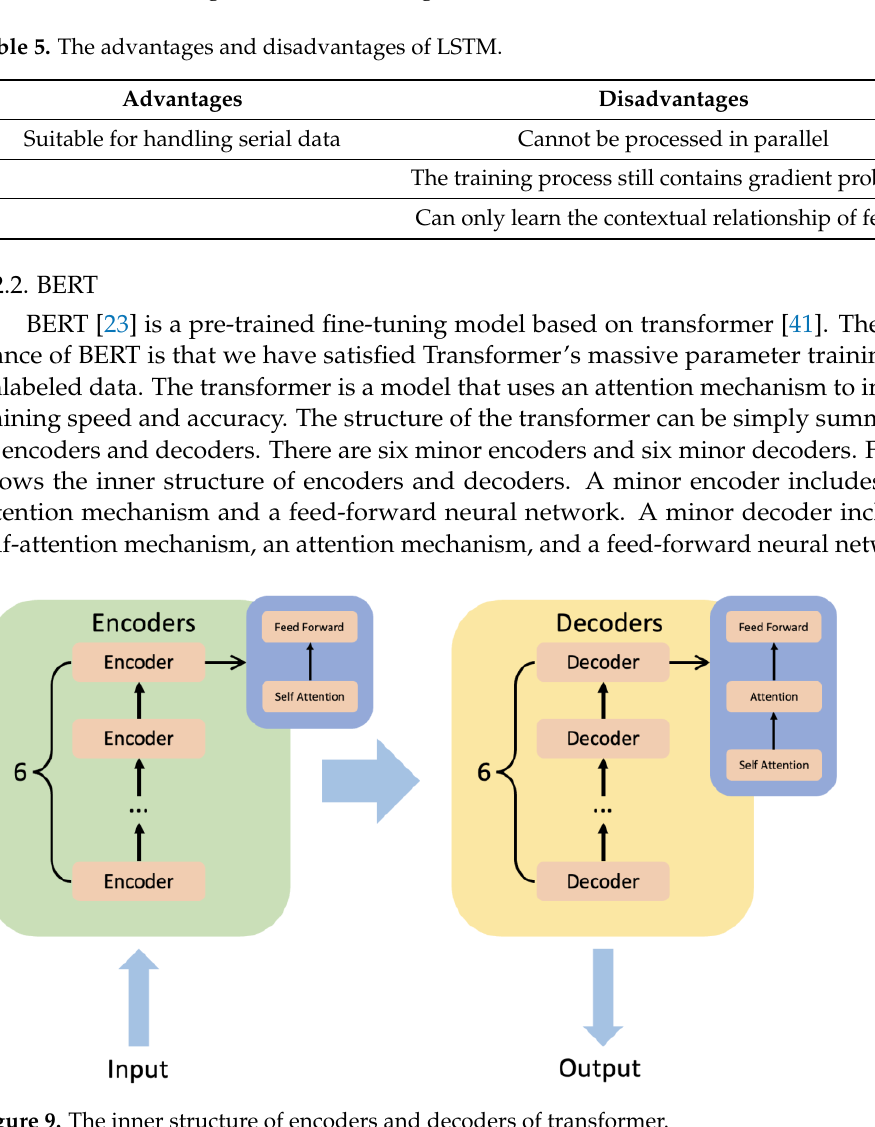
Figure 9. The inner structure of encoders and decoders of transformer.